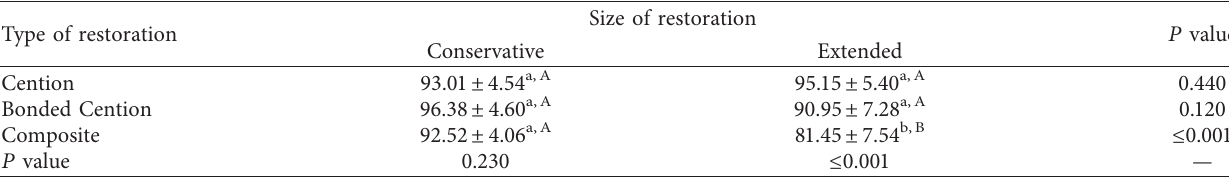
Table 2: Mean ± SD of marginal adaptation (%) of experimental